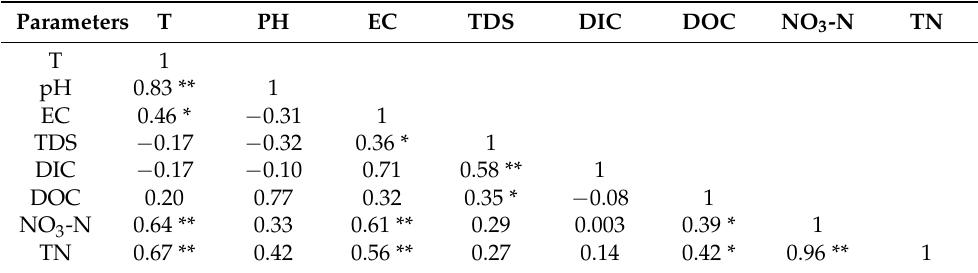
Table 3. Pearson correlation coefficients between C and N species and physicochemical parameters in the Huangzhouhe River